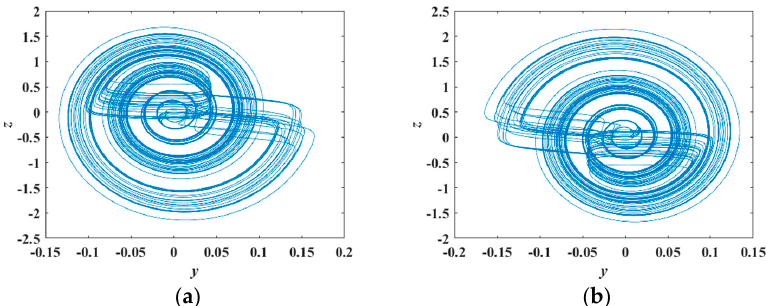
Figure 8. Projections of the attractors on the ( y, z ) plane with different initial conditions: ( a ) (0, 2, 0, 0); ( b ) (0, -2, 0, 0).